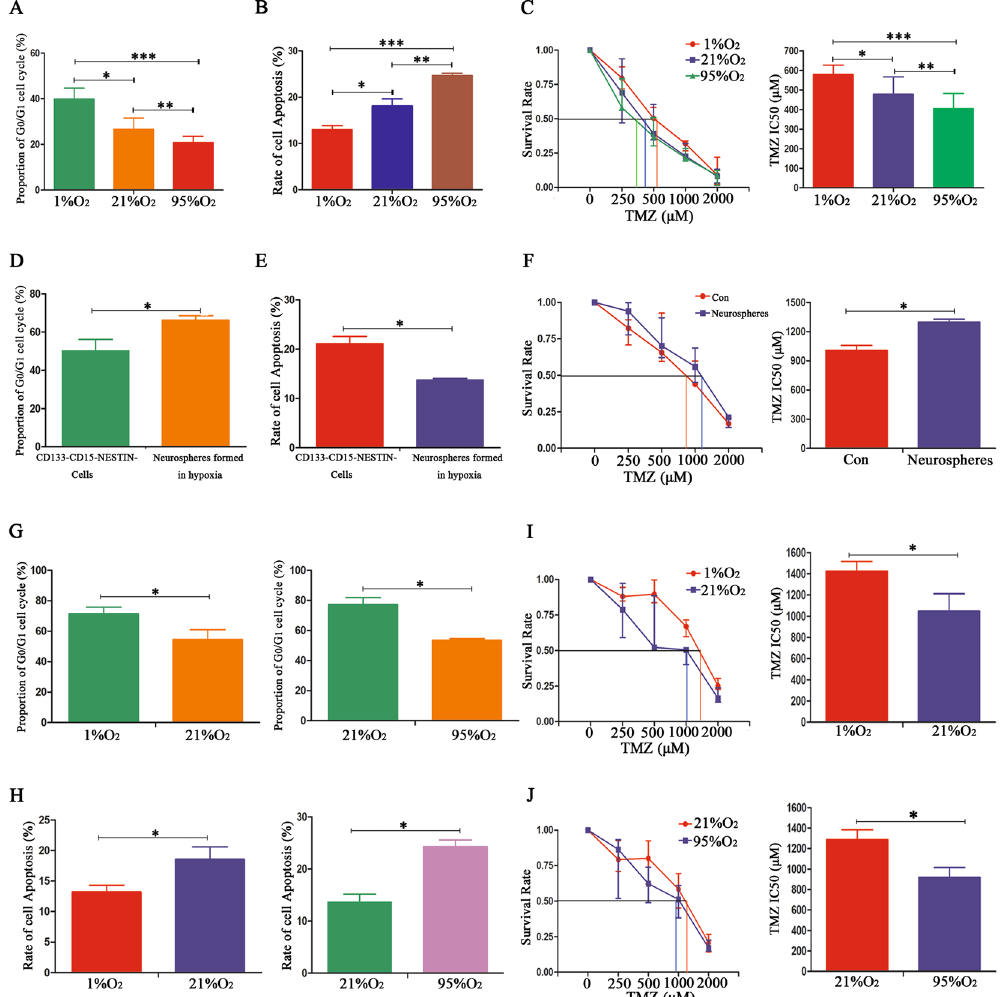
Figure 5. Cell cycle, apoptosis and IC50 detection for glioma cells under different oxygen levels. ( A ) U87 CD133 − /CD15 − /NESTIN − cells arrested in G 0/ G 1 under 1%O 2 conditions compared with 21% O 2 and 95% O 2 ; a normoxic environment promoted more cells arrested in G 0 /G 1 compared with 95%O 2 ( * P < 0.05; ** P < 0.05; *** P < 0.05, One-way ANOVA). ( B ) The lowest apoptosis rate was identified in the 1%O 2 microenvironment for U87 CD133 − /CD15 − /NESTIN − cells after TMZ (100 μ M) treatments, and the cells cultivated in 95%O 2 had the highest cell apoptosis rate ( * P < 0.05; ** P < 0.05; *** P < 0.05, One-way ANOVA). ( C ) Compared with cells in 95%O 2 , there were higher mean IC50 values under 21%O 2 for U87 CD133 − /CD15 − /NESTIN − cells after TMZ treatments, and the mean IC50 values significantly increased in 1%O 2 compared with 21%O 2 . The survival rates of U87 CD133 − /CD15 − /NESTIN − cells after TMZ treatments demonstrated a decrease after an oxygen level increase ( * P < 0.05; ** P < 0.05; *** P < 0.05, One-way ANOVA). ( D ) U87 CD133 + /CD15 + /NESTIN + neurospheres arrested the cell cycle in G 0 /G 1 ( * P < 0.05, Paired-samples T Test). ( E ) A lower apoptosis rate was identified for U87 CD133 + /CD15 + /NESTIN + neurospheres after TMZ (100 μ M) treatments for 48 h than differentiated CD133 − /CD15 − /NESTIN − cells with the same TMZ treatments ( * P < 0.05, Paired-samples T Test). ( F ) GL261 CD133 + /CD15 + /NESTIN + neurospheres had a higher survival rate after TMZ exposure than CD133 − /CD15 − /NESTIN − cells. The mean IC50 values of GL261 CD133 + /CD15 + /NESTIN + neurospheres were 1.4-fold higher than differentiated CD133 − /CD15 − /NESTIN − cells ( * P < 0.05, Paired-samples T Test). ( G ) U87 CD133 + /CD15 + /NESTIN + cells arrested in the G 0 /G 1 state in 1%O 2 conditions compared with normoxia; there were more arrested in G 0 /G 1 in normoxic compared with hyperoxic environments ( * P < 0.05, Paired-samples T Test). ( H ) U87 CD133 + /CD15 + /NESTIN + cells treated with TMZ (100 μ M) exhibited a lower apoptosis rate in the hypoxic environment than normoxia or hyperoxia ( * P < 0.05, Paired-samples T Test). ( I ) U87 CD133 + /CD15 + /NESTIN + cells in 1%O 2 conditions had a higher survival rate after TMZ treatment, and the mean IC50 value was approximately 1.3-fold higher than the control normoxic treatment cells ( * P < 0.05, Paired-samples T Test). ( J ) Hyperoxia had opposite effects for U87 CD133 + /CD15 + /NESTIN + cells treated with TMZ, which exhibited a lower survival rate and IC50 values ( * P < 0.05, Paired-samples T